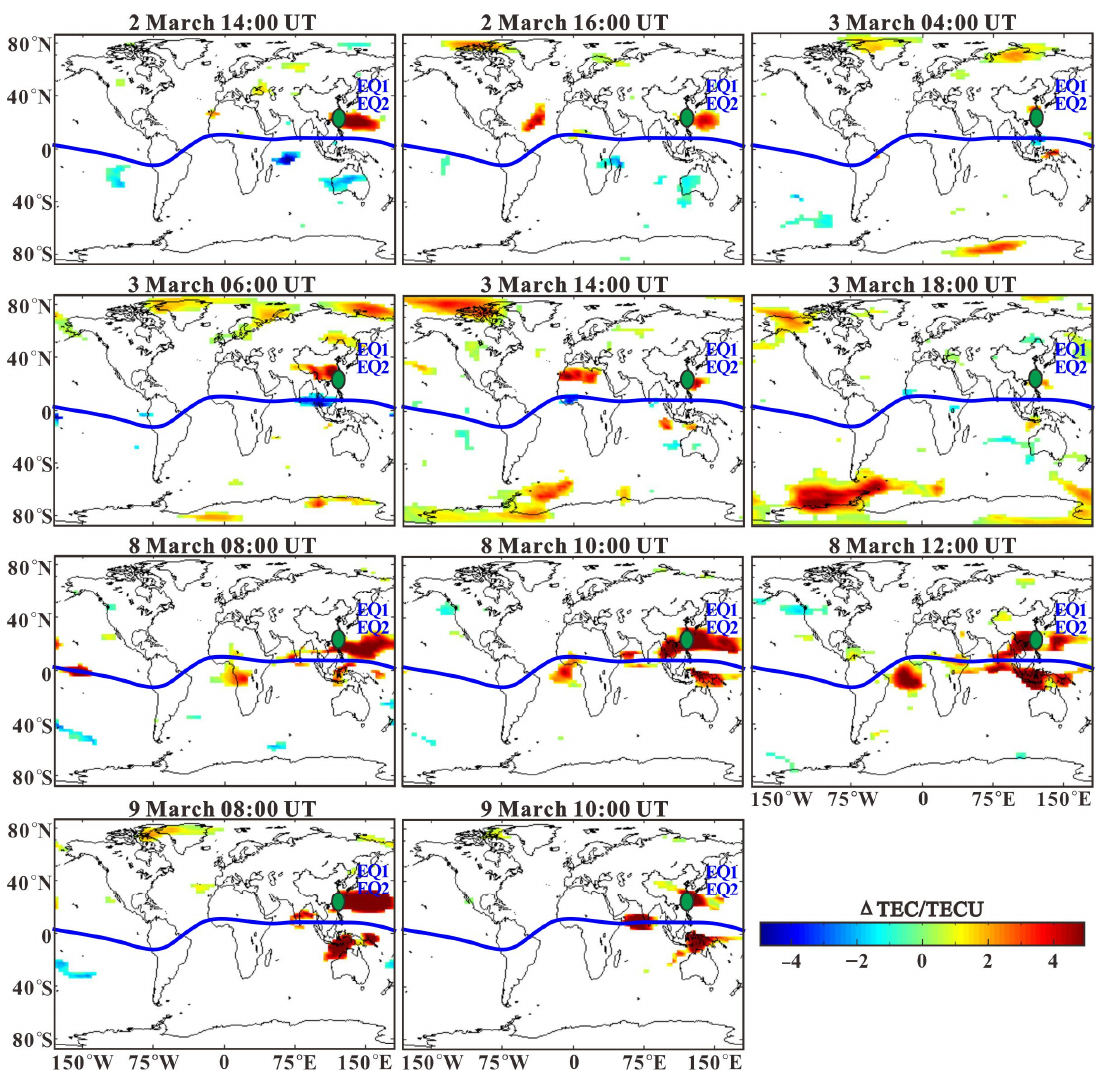
Figure 4. GIM TEC global ionospheric anomaly maps. TEC anomalies occurred from 14:00 ( top left ) to 16:00 UT ( top middle ) on 2 March; from 04:00 ( top right ) to 06:00 ( upper middle left ) and at 14:00 ( upper middle centered ) and 18:00 ( upper middle right ) UT on 3 March; from 08:00 ( upper lower left ), 10:00 ( upper lower centered ) to 12:00 ( upper lower right ) UT on March 8; and from 08:00 ( bottom left ) to 10:00 ( bottom right ) UT on 9 March 2022. The green ellipse is the earthquake prep- aration zone of EQ1. The blue line is the magnetic equator. The TEC is measured in TECU units (1 TECU = 10 16 el/m 2 ).